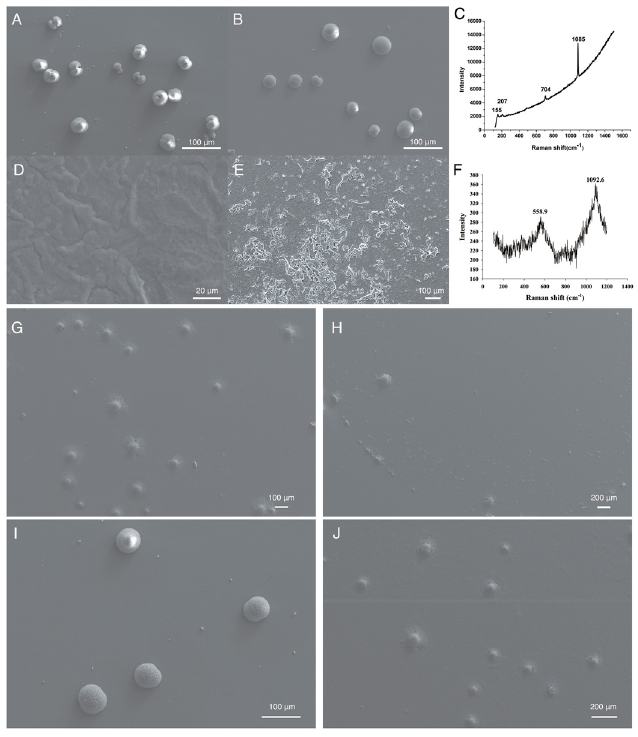
Fig 6. SEM images of in vitro crystallization of aragonite in the presence of rKRMP-3, rBR, rGYR and Raman spectrum analysis. Crystals were grown in the presence of 50 mM MgCl 2 with 10 μ g/ml GST(A), 2 μ g/ml rKRMP-3 (B), 10 μ g/ml rKRMP-3 (D, E) and 2 μ g/ml rBR (G), rGYR (I), 10 μ g/ml rBR (H), rGYR (J). Raman spectra showed the typical crystals formed in A, B, I were aragonite, with the characteristic peaks at 207, 704, and 1085 cm -1 (C). Raman spectra of the material precipitated in the presence of 10 μ g/ml rKRMP- 3 (C, D) showed the absorption peaked at 558.9 and 1092.6 cm – 1